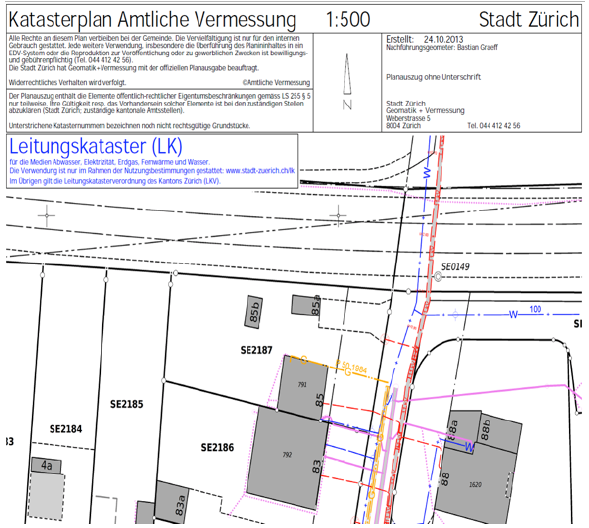
Figure 1. Example of print out of utility cadaster (Source: Leitungskataster, Stadt Zurich, 2017).